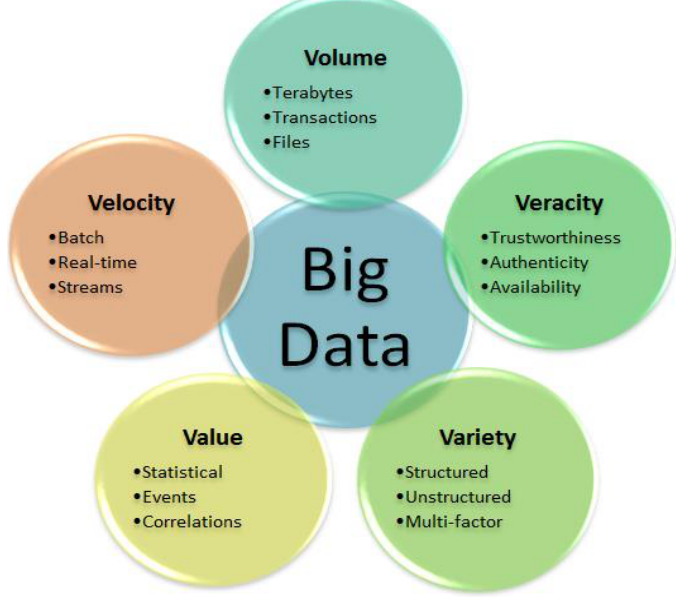
Figure 1. The 5Vs of Big Data and their major characteristics.